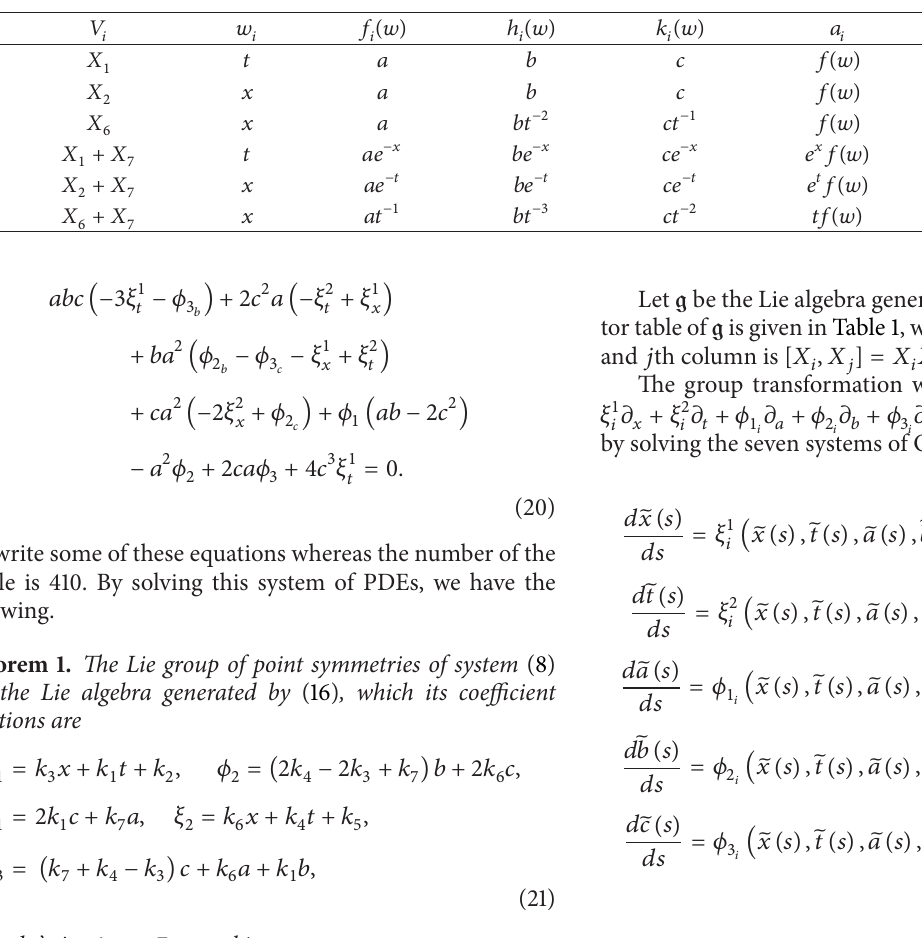
Table 2: Lie invariants and similarity